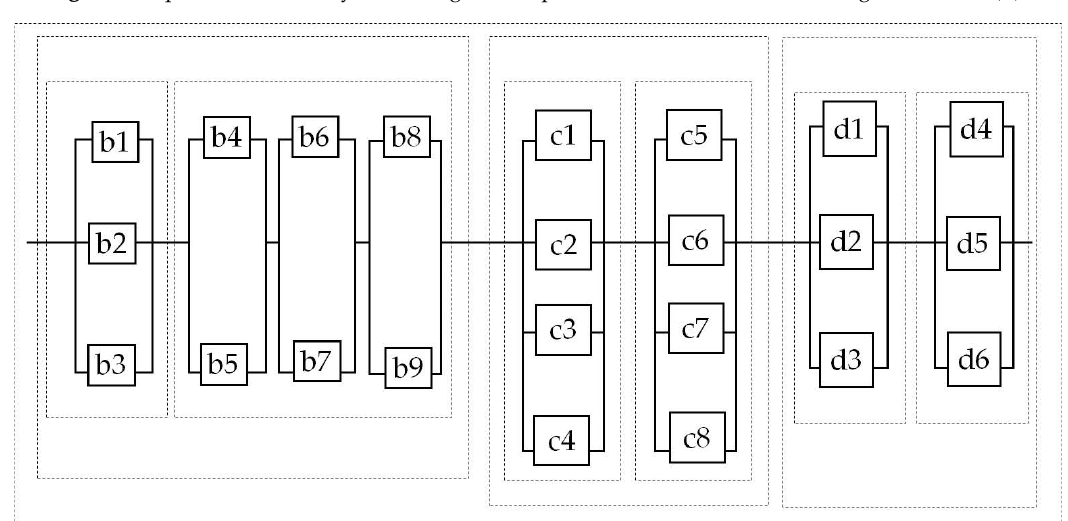
Figure 9. Global reliability block diagram integrating equivalent reliability block diagrams of each resultant fault tree